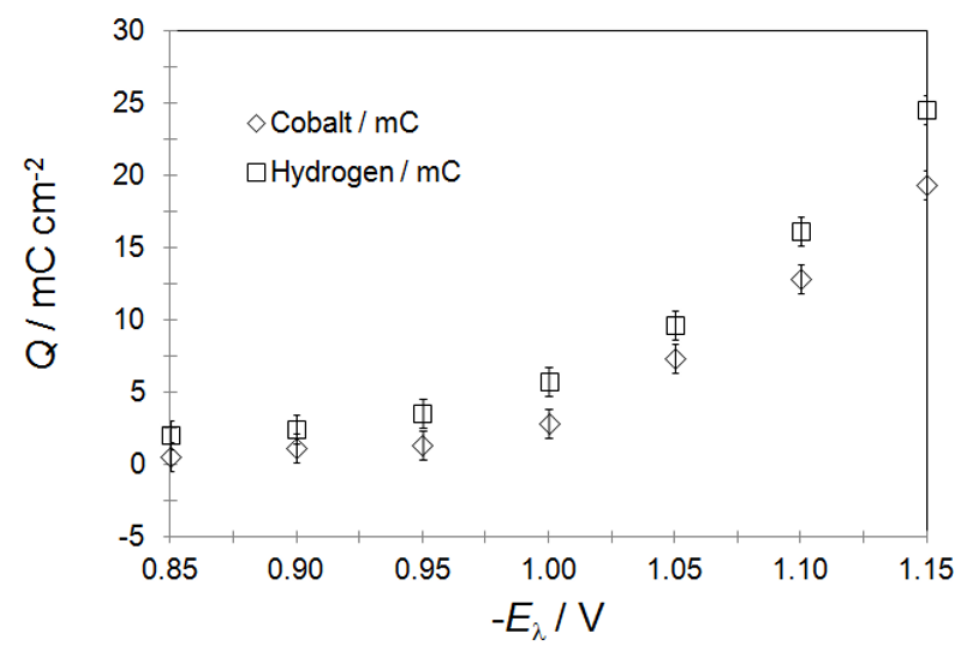
Figure 3. Cathodic charges associated to the cobalt and hydrogen reduction processes at different inversion